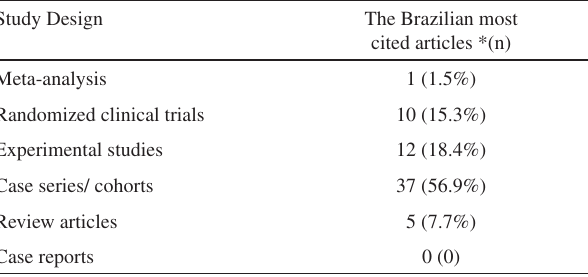
Table 3 - The Brazilian most-cited articles by study